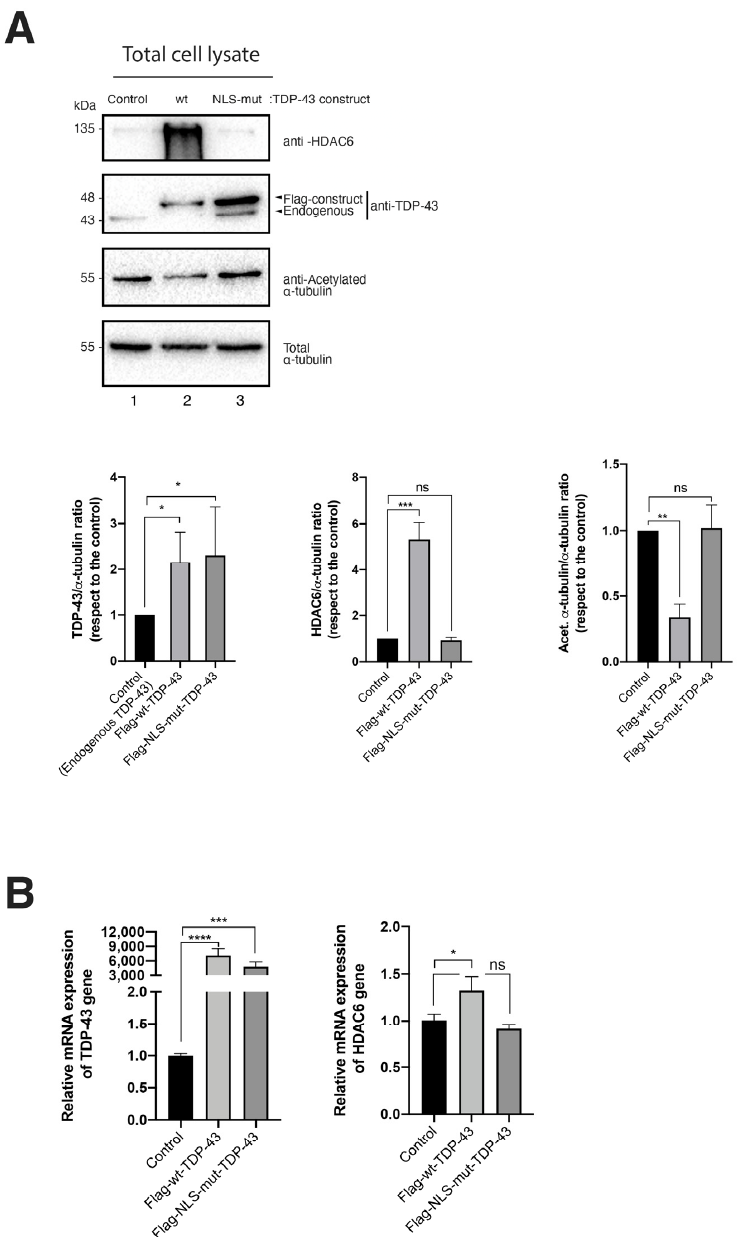
Figure 1. Overexpression of TDP-43 increases HDAC6 mRNA and protein levels. ( A ) Quantitative biochemical analysis of whole cell lysate of HEK-293T cells overexpressing Flag-wt-TDP-43 (line 2 condition) or the Flag-NLS-mut-TDP-43 construct (line 3 condition) and their effect on endogenous HDAC6 and MTs α -tubulin acetylation, with respect to control condition (line 1). Acetylated α -tubulin levels are a read-out for MT stabilization that decrease after increasing tubulin-deacetylase HDAC6. Total α -tubulin for protein load control is shown, under each experimental condition. A representative experiment of three is shown (see replicate data in Figure S1, Supplementary Materials section). Bottom : Histograms quantify the intensities of western blot bands from the left panel experiment, representing the amounts of TDP-43 constructs (Flag-wt-TDP-43 and Flag-NLS-mut-TDP-43) compared to endogenous TDP-43 (control), HDAC6, and acetylated α - tubulin. Data are normalized by total α -tubulin load control per each experimental condition. Data are mean ± standard error of the mean (S.E.M.) of three independent experiments (data associated with the quantification of replicates in Figure S1, Supplementary Materials section). When indicated, *** p < 0.001 and ** p < 0.05 are p values for Student’s t test. ns stands for non-significant. ( B )